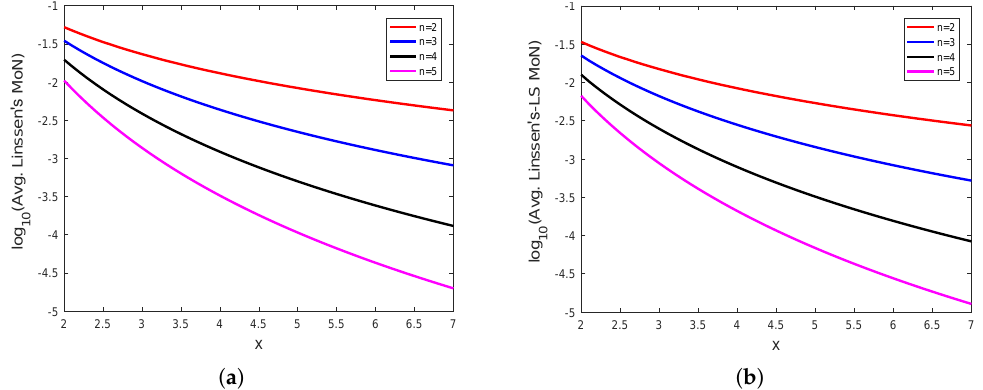
Figure 9. ( a ) Logarithm of Linssen’s MoN (log (Avg. Linssen’s MoN)) vs. x and ( b ) logarithm of 10 Linssen’s MoN using LS (log (Avg. Linssen’s-LS MoN) vs. x with 10 scalar 10